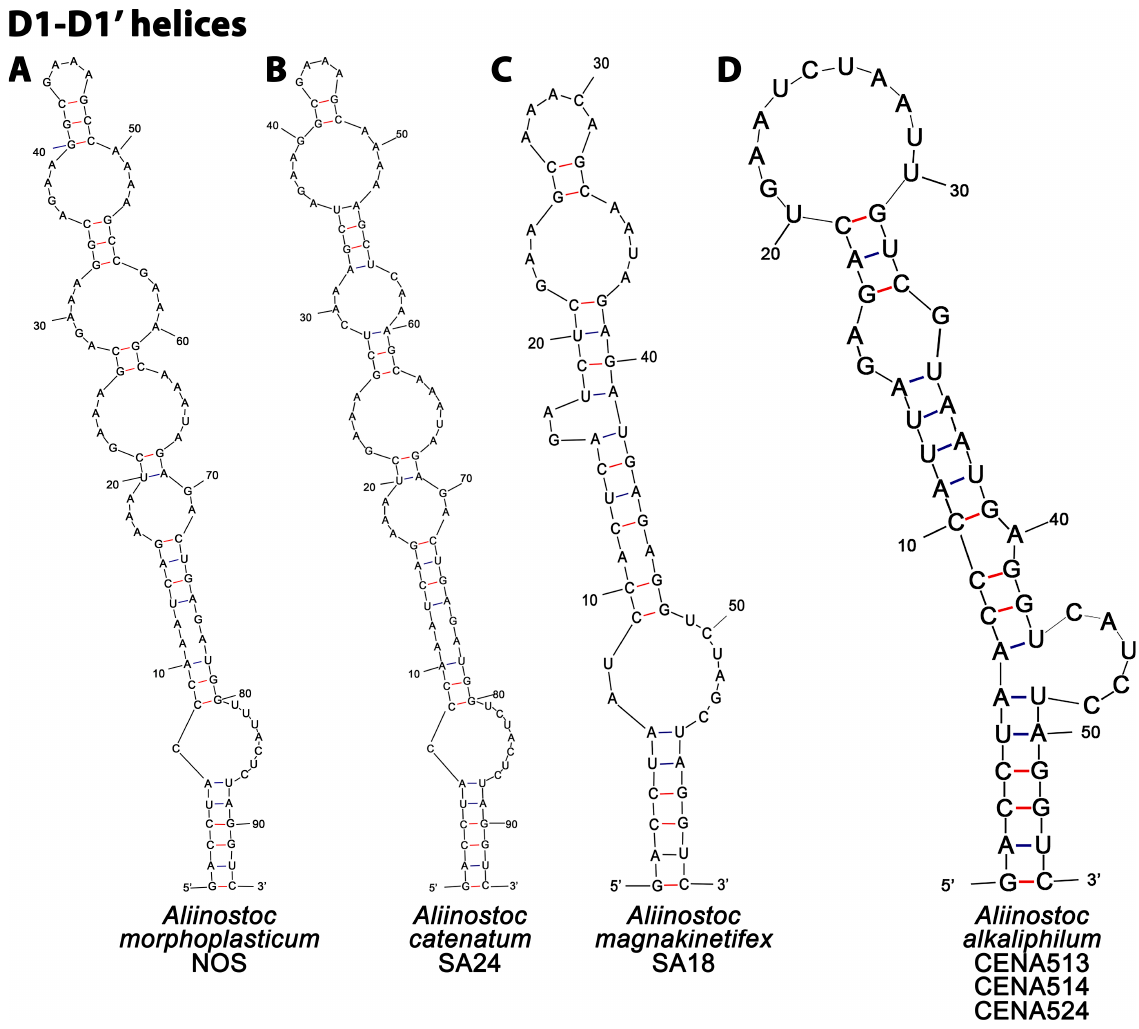
Figure 4. Hypothetical secondary structures of conserved D1-D1 ′ region of the 16S-23S ITS regions of Aliinostoc species identified in operons lacking tRNA genes. ( A ) Aliinostoc morphoplasticum NOS (KY403996). ( B ) A. catenatum SA24 (MK503792). ( C ) A. magnakinetifex SA18 (MK503791). ( D ) A. al- kaliphilum CENA513 T , CENA514 and CENA524 (OK042917, OK042919 and OK042921, respectively).